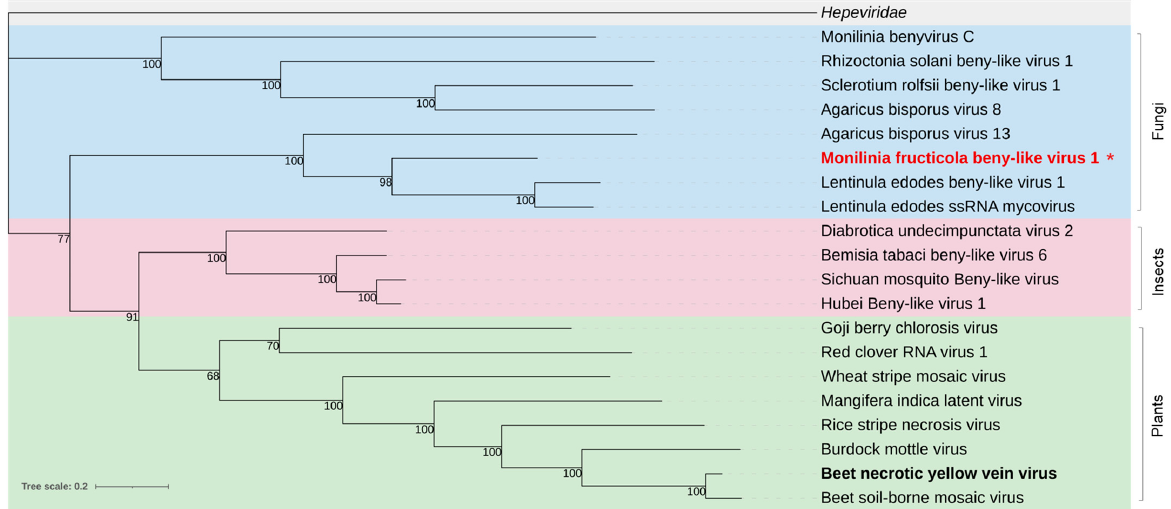
Figure 6. Maximum likelihood phylogenetic tree based on multiple amino acid sequence alignment of the nonstructural replication-associated protein of Monilinia fructicola beny-like virus 1 and beny-like viruses ( Benyviridae family) from various hosts, including fungi (blue), insects (pink), and plants (green). The Hepeviridae family (grey) was used as outgroup. The type species is in bold black. The mycovirus found in this work is in bold red. The asterisk indicates the newly proposed species. The number on the nodes, shown for values greater than 50%, are the results of 1000 bootstrap analyses. The scale bar represents a genetic distance of 0.2 amino acid substitutions per site. The list of accession numbers of the analysed sequences is in Table S1.